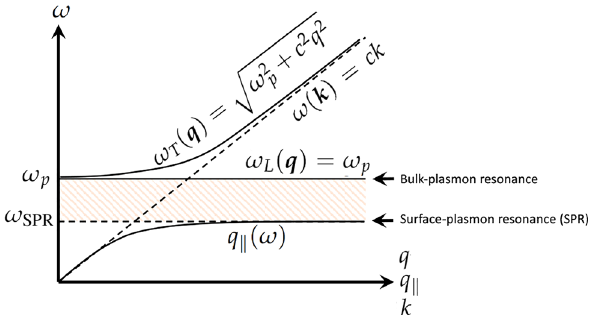
Figure 2: Surface-plasmon dispersion relation (Eq. (10b)), indicating also the dispersion of transverse waves above the plasma frequency, and the nondispersive (due to the local-response approximation) bulk plasmons at the plasma frequency. For comparison, the linear dispersion of photons in a vacuum is also shown